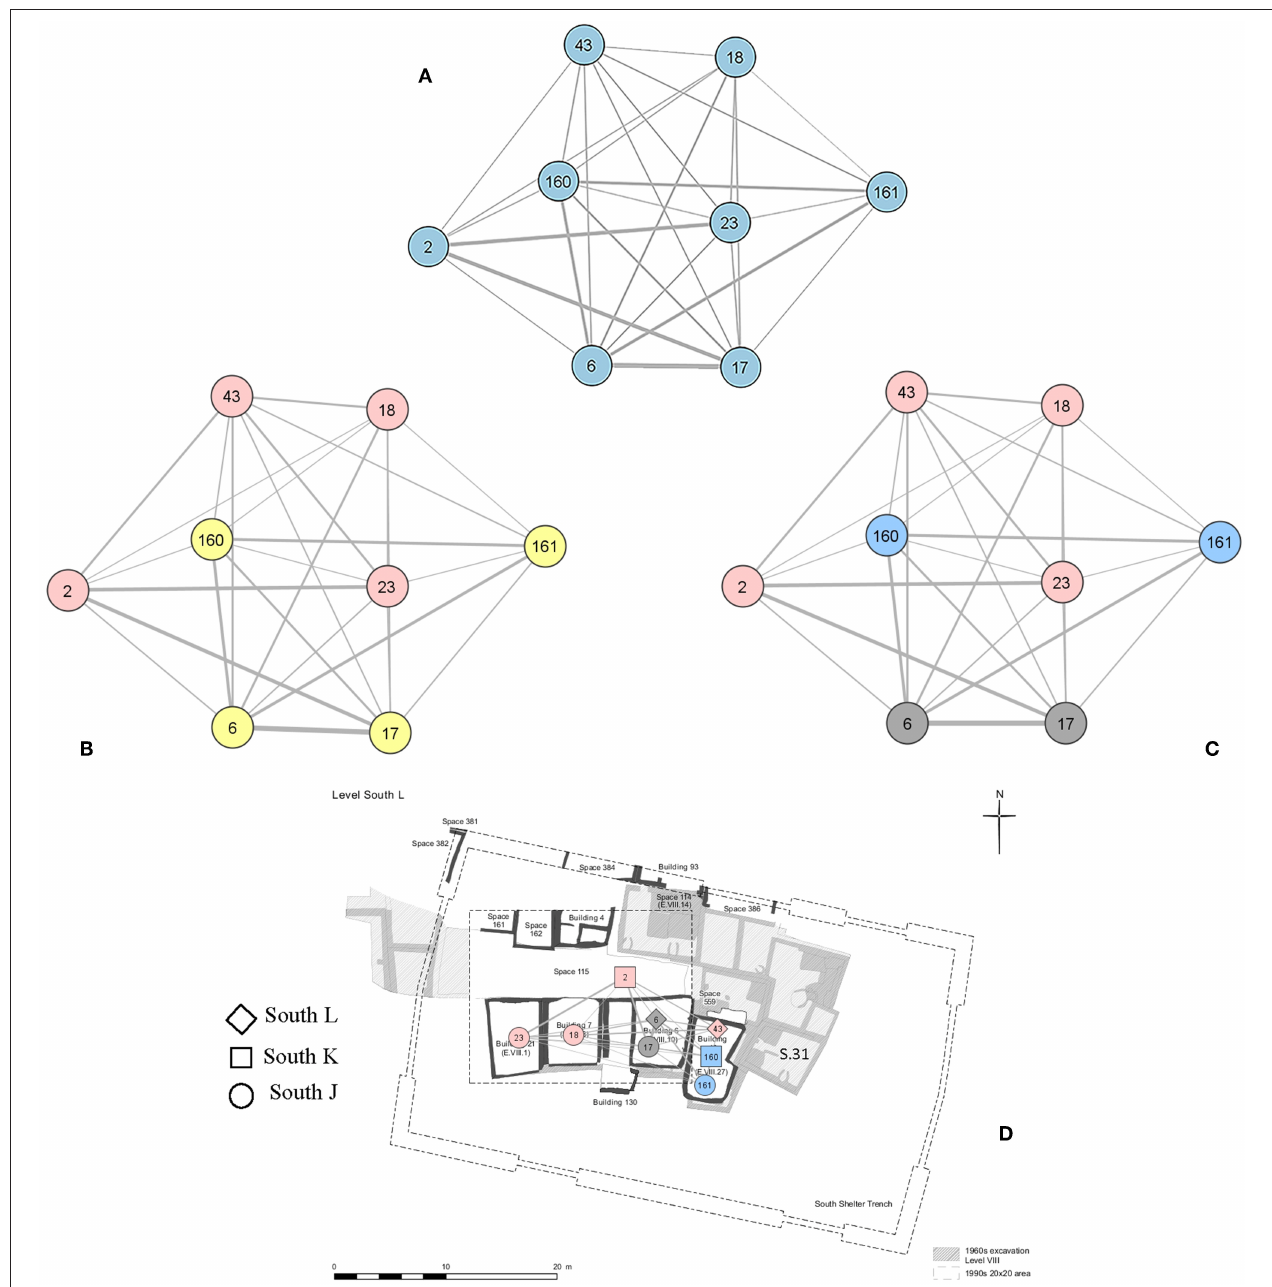
FIGURE 5 | Early network (A) . Louvain algorithm partition: layer 1 (B) and layer 2 (C) . Early network overlapped to the South Area excavation map (South L) (D)